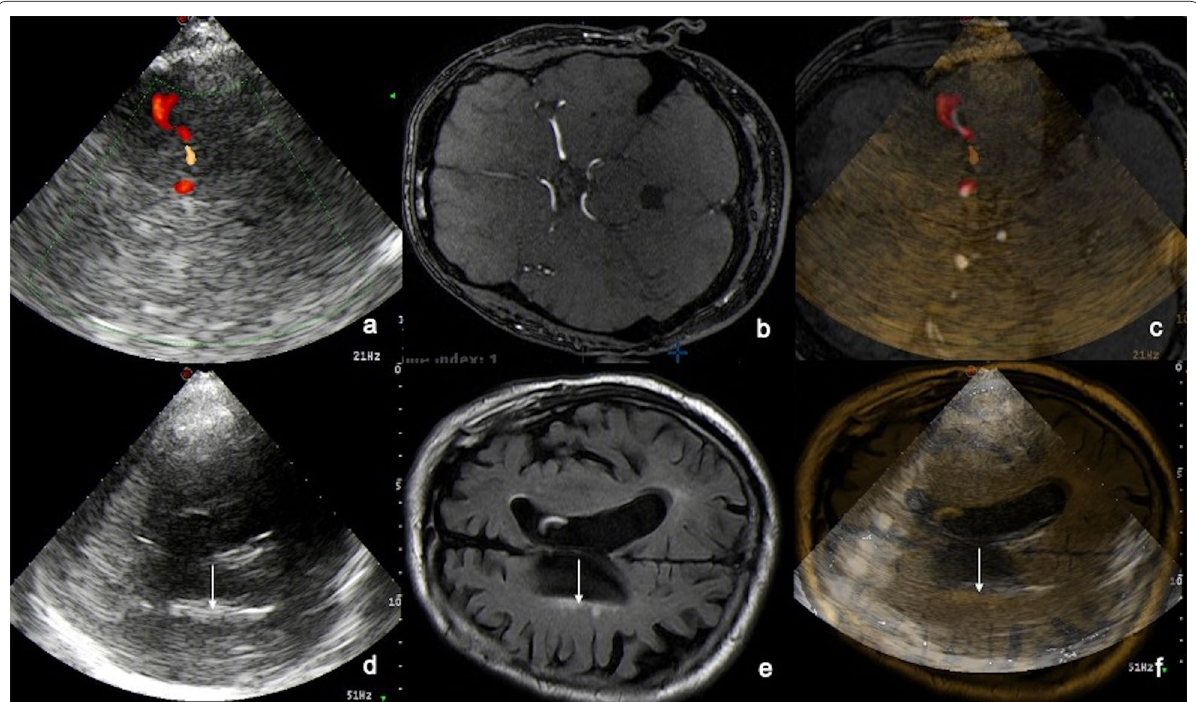
Fig. 1 Fusion procedure of ultrasound (US) and MR images. The ipsilateral middle cerebral artery (MCA) is determined as anatomical landmark. After US visualization of the ipsilateral MCA in color-coded duplex ultrasonography (TCCS), axial scanning approach, US images are fused with the corresponding MR images (TOF-sequence) and corrected, if necessary, to match perfectly ( a–c ). During UFI investigation MR FLAIR images are used for online examination ( d – f ). a–c : Left: TCCS MCA ipsilateral. Middle: MR TOF angiography. Right: Fused images. d–f : Left: TCS in B-Mode. Middle: cerebral MR FLAIR image, axial plane. Right: fused images US and MRI. White matter lesions (WMLs) II, Anterior horn contralateral. White arrows indicate the